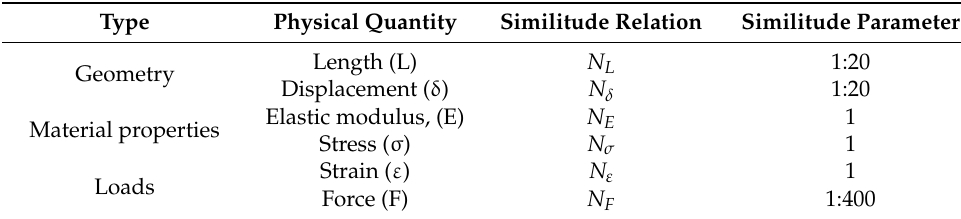
Table 1. Similitude relation.